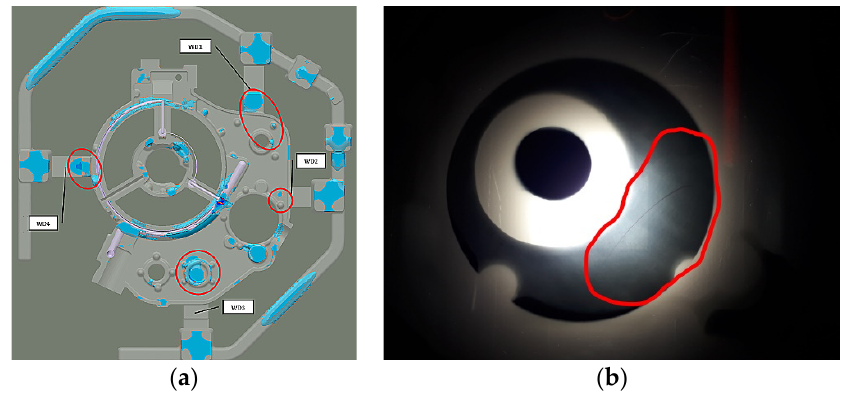
Figure 6. Stage 1 ( a ) Porosity in feeding gates areas; ( b ) Corresponding X-ray image.